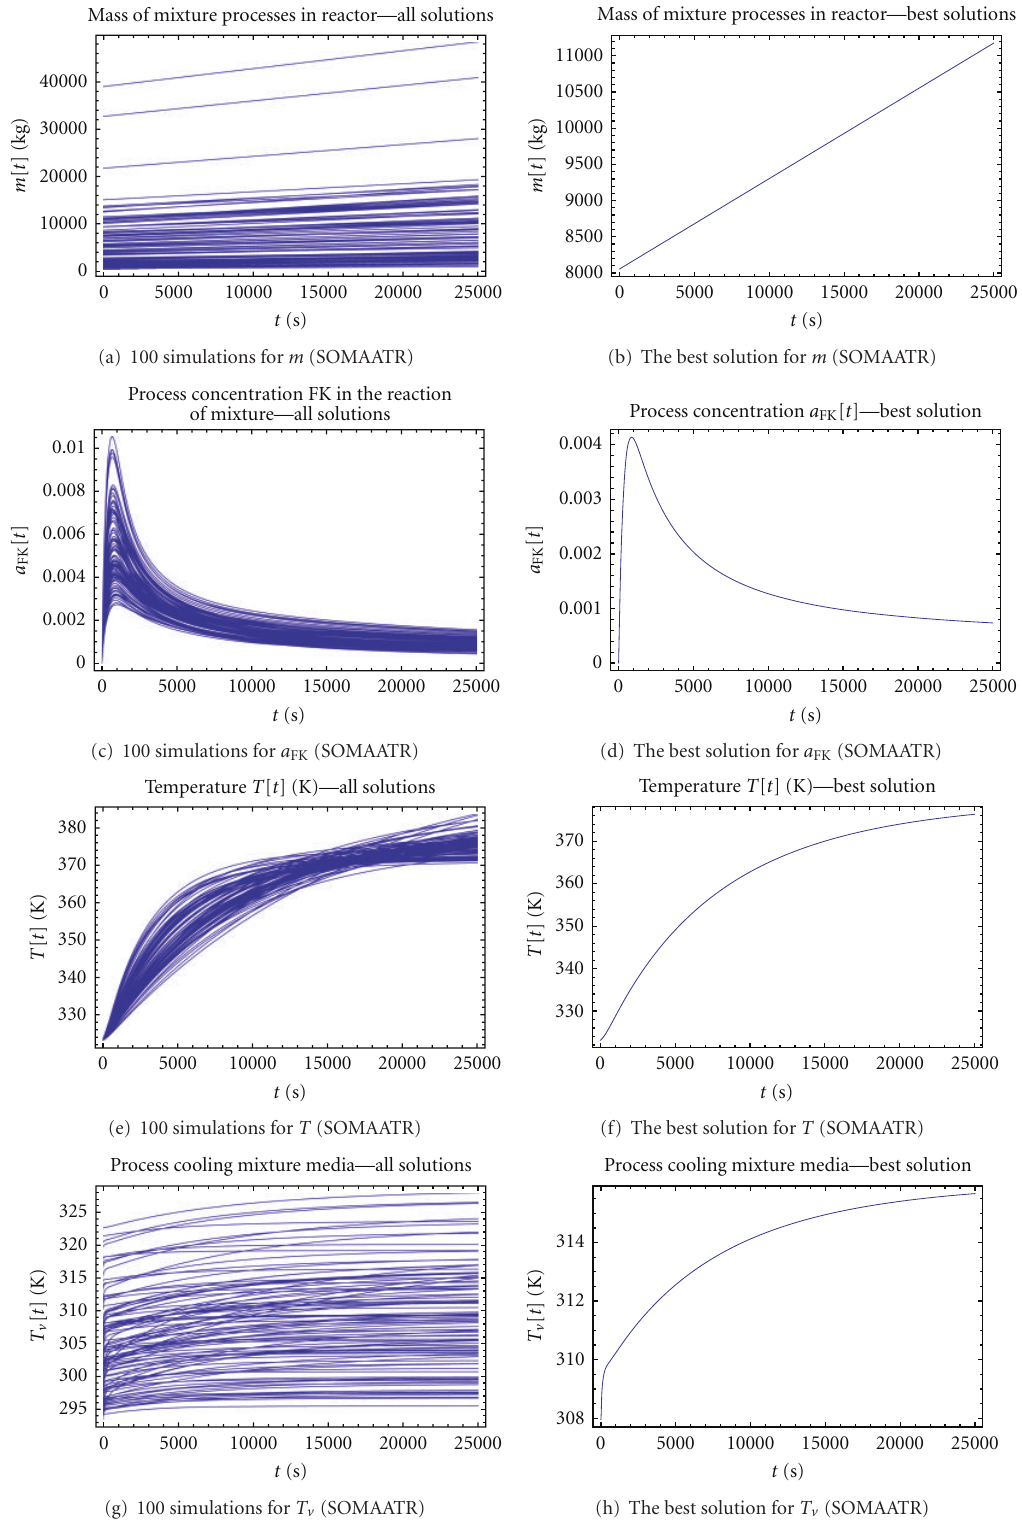
Figure 6: Processes parameters for 100 simulations of SOMA—version